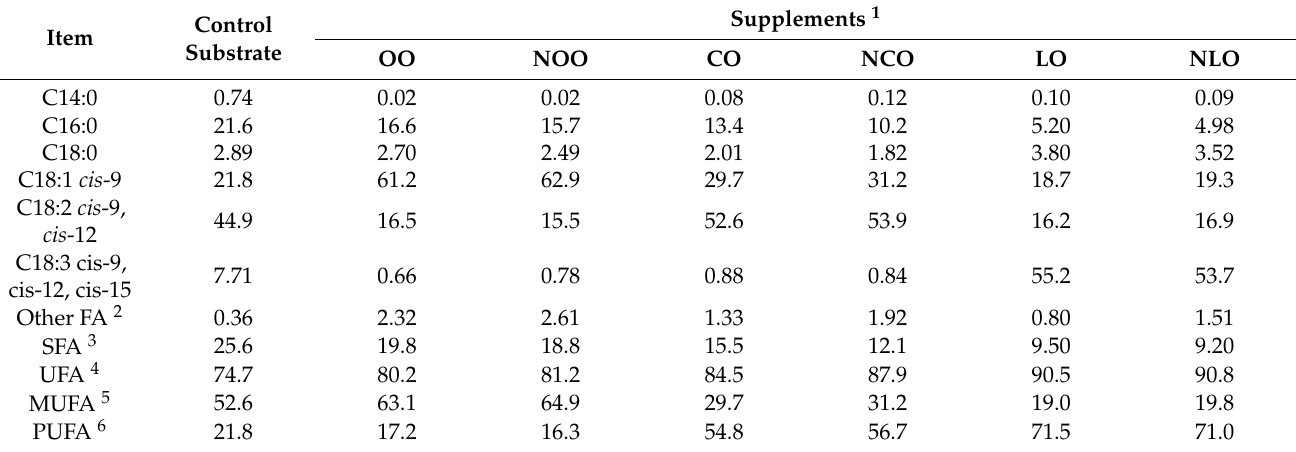
Table 2. Fatty acid composition (g/100 g of FA) of the control substrate and